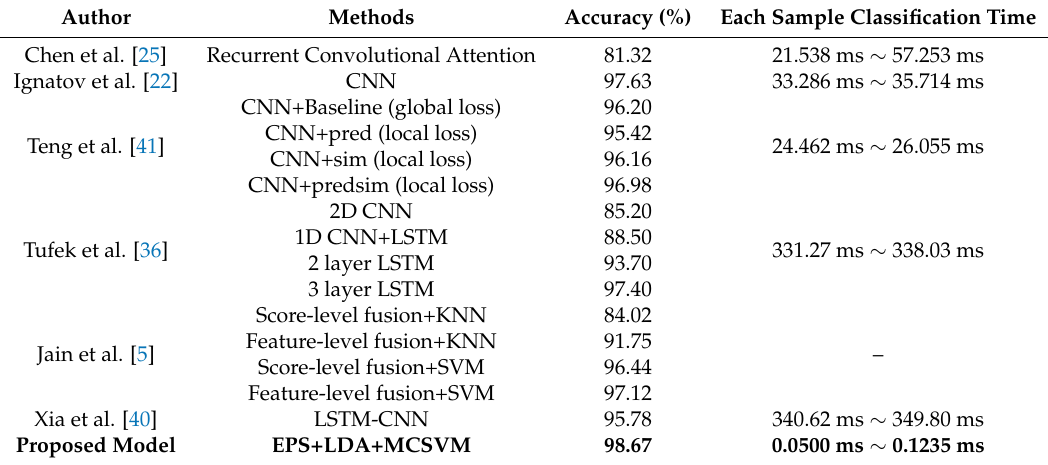
Table 6. Performance comparison of the proposed model with other sate-of-the-art models on the UCI-HAR